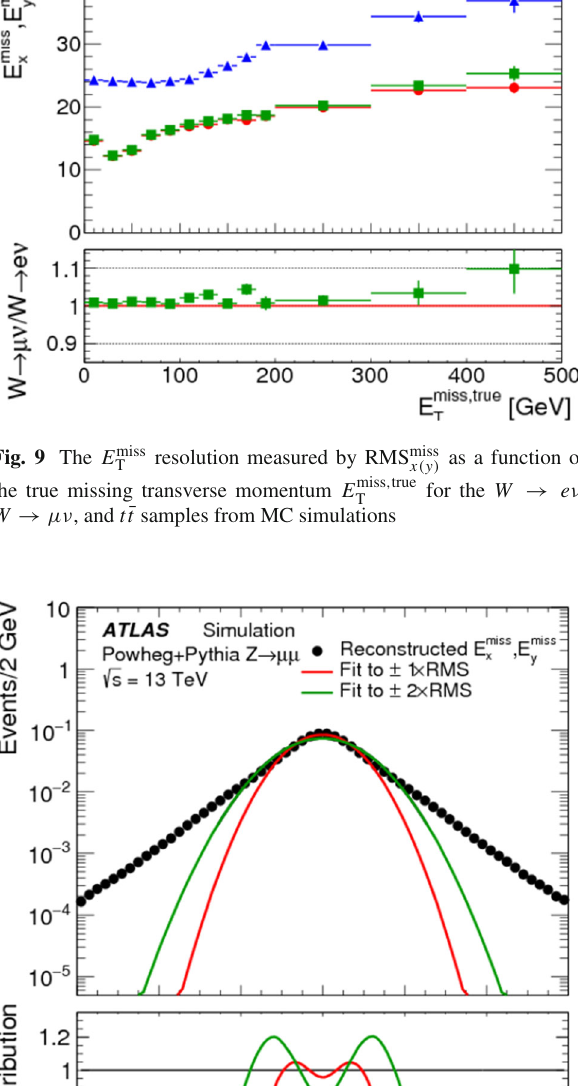
Fig. 10 The combined distribution of E miss x and E miss y for an inclusive Z → μμ from simulation. Gaussian fits limited to the ± 1 × RMS and ± 2 × RMS ranges around the centre of the distribution are shown, together with the respective differences between the fitted functions and the actual distribution